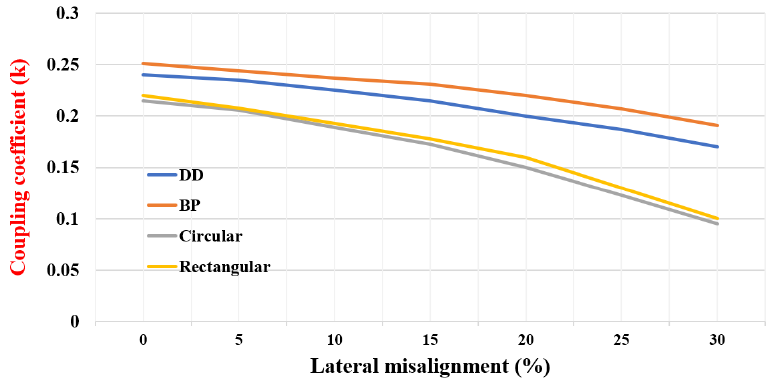
Figure 6. Comparison performance of different coils under various lateral misalignment conditions.